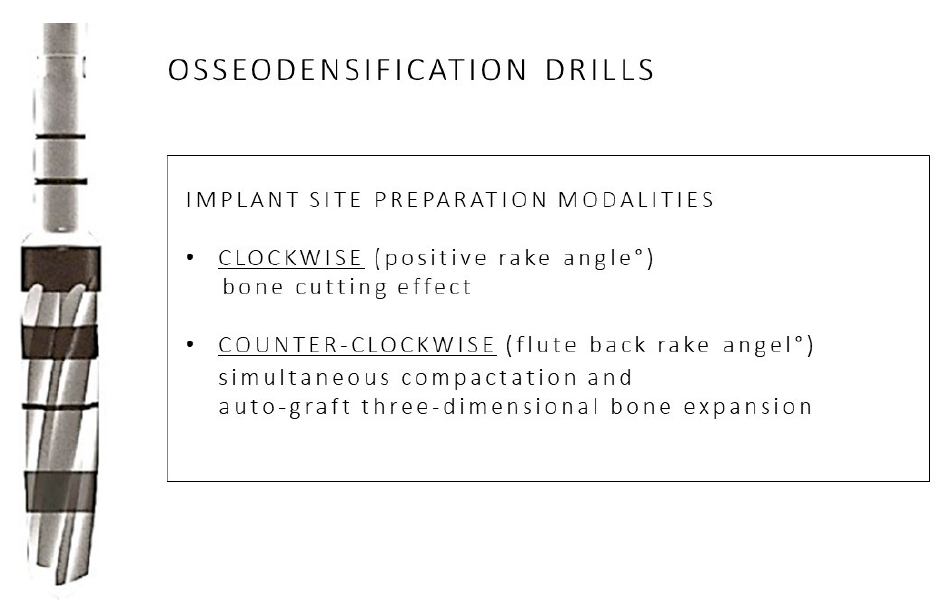
Figure 3. Main characteristics of the osseodensification drilling technique: details of clockwise and counterclockwise implant site preparation modalities.